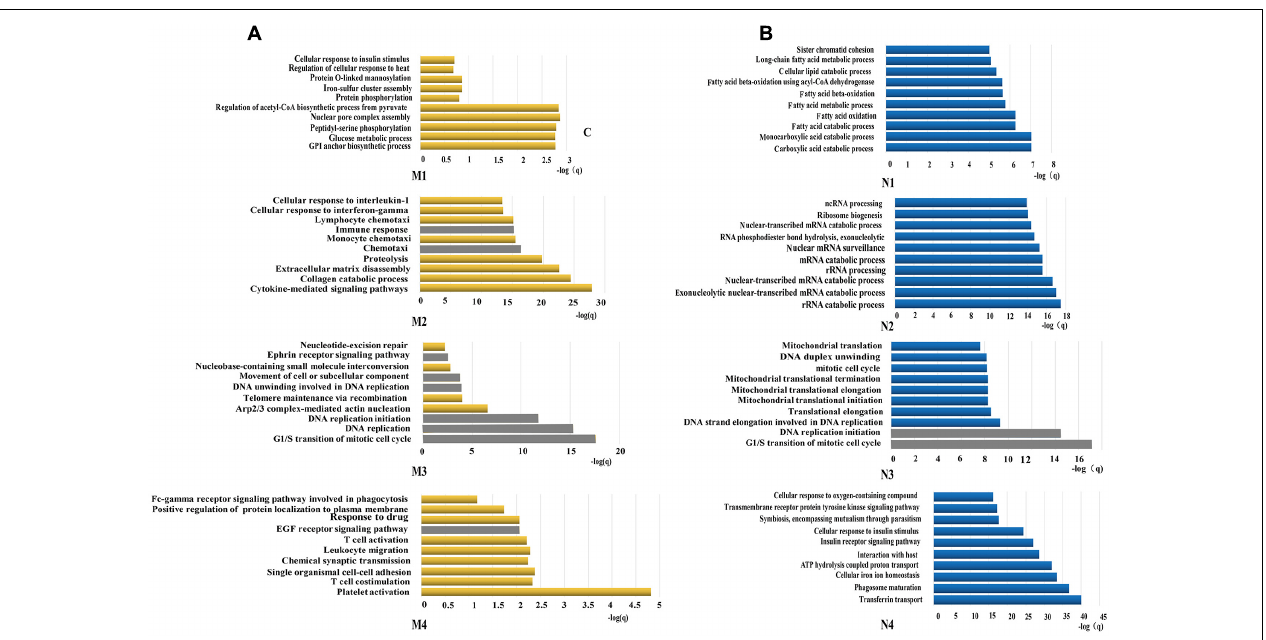
FIGURE 2 | Functions predicted by the bioinformatic analysis. (A) Represents the top 10 predicted functions of P311 in modules from dataset 1. (B) Represent the top 10 predicted functions of P311 in modules from dataset 2. Gray squares stand for the predicted common functions.